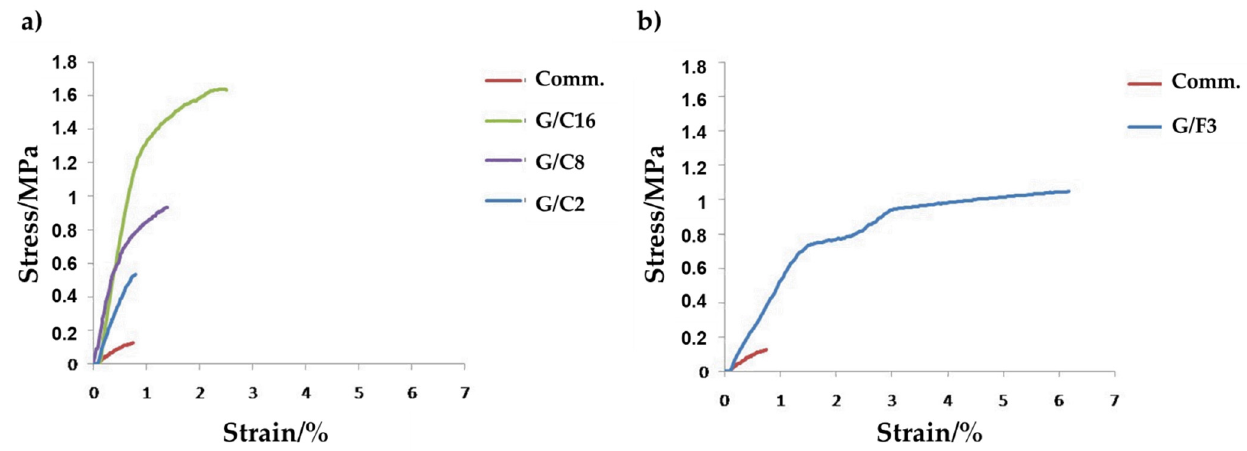
Figure 11. Stress/strain curves of the coatings G/C16, G/C8 and G/C2 ( a ) and G/F3 ( b ), compared to commercial coating.